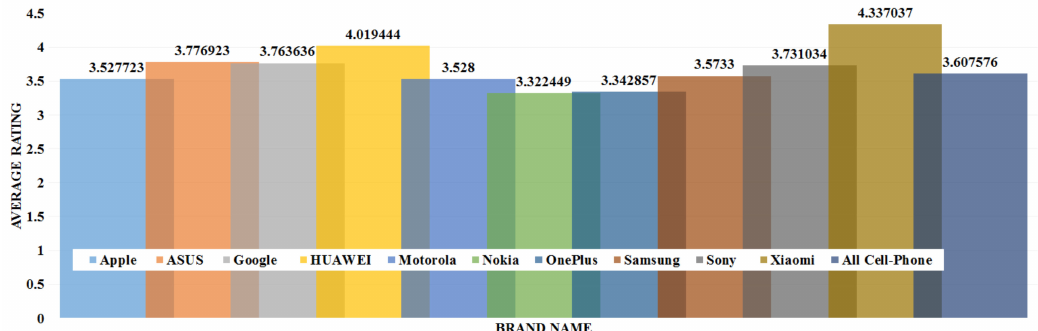
Figure 4. Average rating of the mobile phone